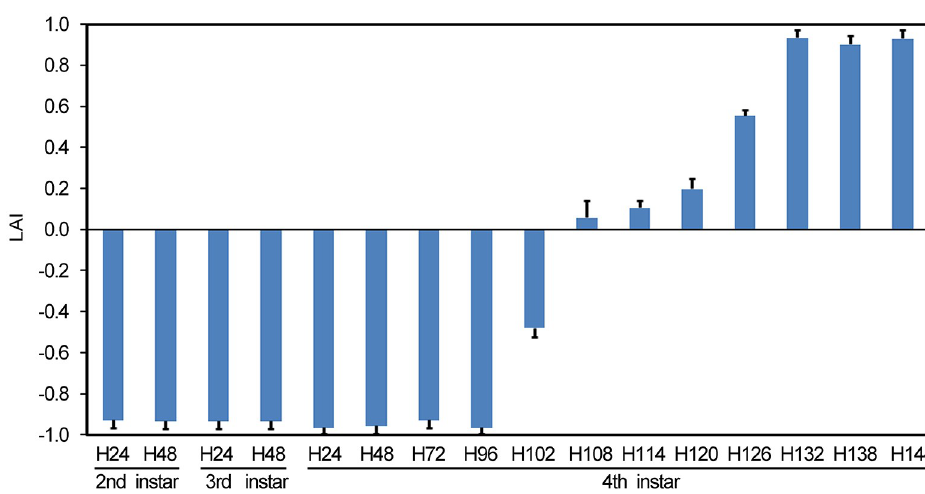
Fig 1. A phototaxis switch of the wandering larvae. A two-choice test in laboratory. Light avoidance indexes (LAI) were assessed for second-instar (SI), third-instar (TI) and foraging fourth-instar (FI) larvae (D1-D4 indicates day 1 to day 4 after ecdysis) at an interval of a half day, and from 4.0 to 6.0 days at an interval of six hours.